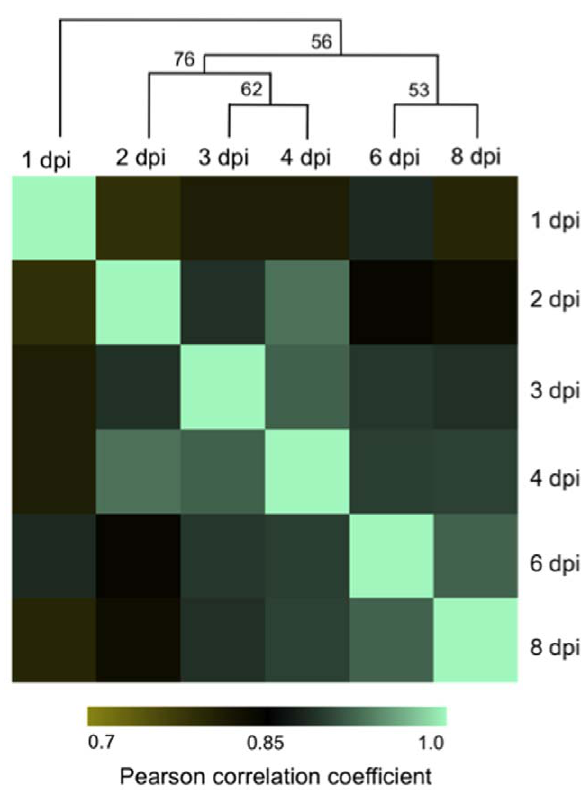
Figure 4. Correlation matrix of Cucumis sativus expression profiles during infection by Pseudoperonosporacubensis . Tissue samples were collected from C. sativus at different time points of infection with Ps. cubensis . Normalized transcript abundances for 14,476 genes were calculated as fragments per kilobase pair of exon model per million fragments mapped (FPKM) with Cufflinks version 0.9.3 [58]. Pearson correlation coefficient of log2 FPKM values were calculated for all pair-wise comparisons using R (http://cran.r-project. org/). Hierarchical clustering was performed using Pearson correlation distance metric and average linkage with the Multiple Experiment Viewer Software version 4.5 [60]. The bootstrap support values shown on tree nodes were obtained from 1000 bootstrap replicates. dpi, days post-inoculation. responses to hyphal penetration, hyphal growth and haustorium formation. The clustering of gene expression at later time points (6 and 8 dpi) likely corresponds to similar symptoms observed (Figure 1) as well as plant responses to extensive Ps. cubensis hyphal growth that is occurring at those time points [36].